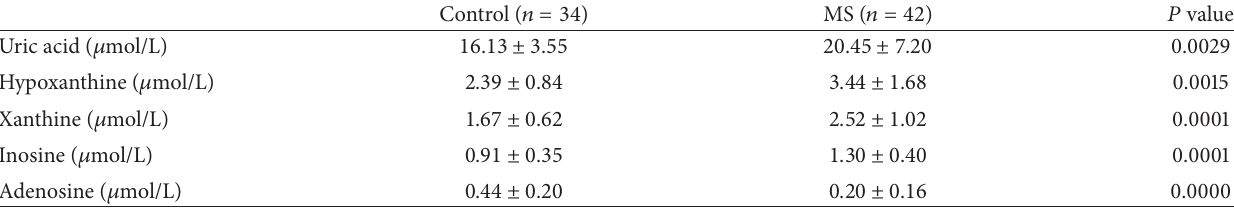
Table 2: CSF levels of purine nucleotide degradation products in patients with multiple sclerosis (MS) and in the control group.